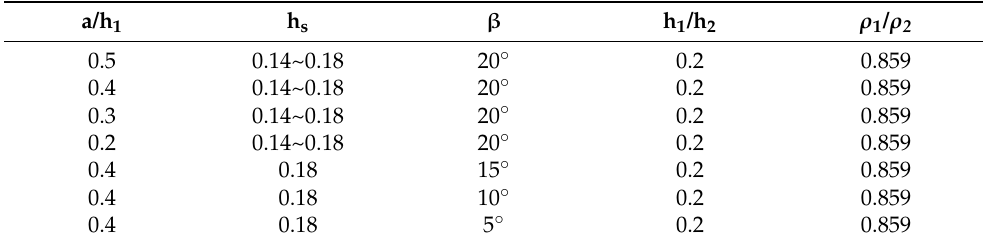
Table 1. Main parameters of performed simulation cases.